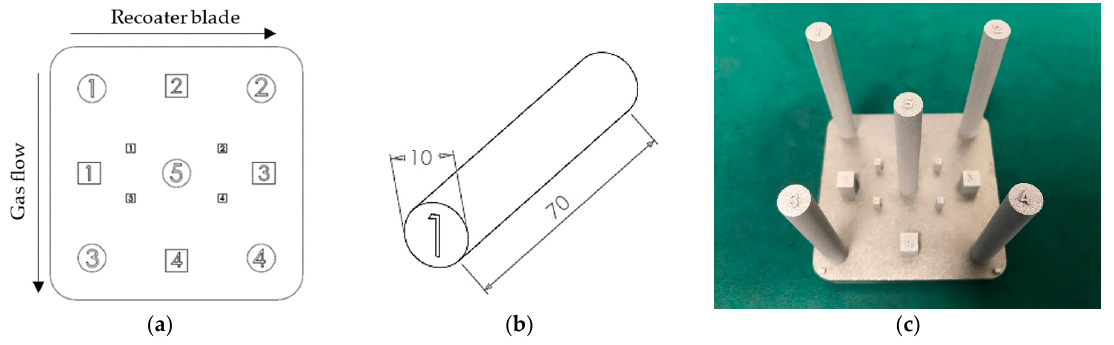
Figure 3. Test-part build design providing ( a ) top view of the test-part build, ( b ) the geometry of a cylindrical samples used for tensile and hardness testing, and ( c ) final parts on the build plate.